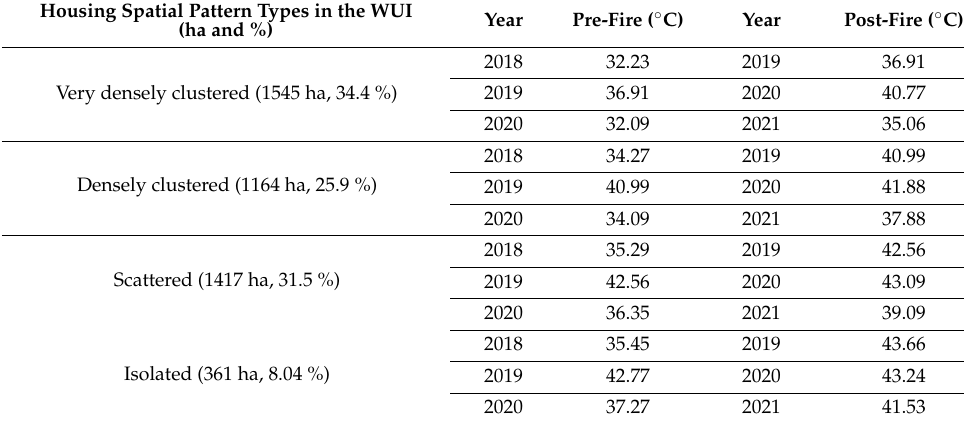
Table 2. Housing spatial categories, surface area (ha), percentage of the study area, and mean LST (°C) of the types of housing spatial patterns and land use and vegetation cover in the WUI of the MACG. Housing Spatial Pattern Types in the WUI ◦ C) (ha and %) Year Pre-Fire ( Very densely clustered (1545 ha, 34.4 %)